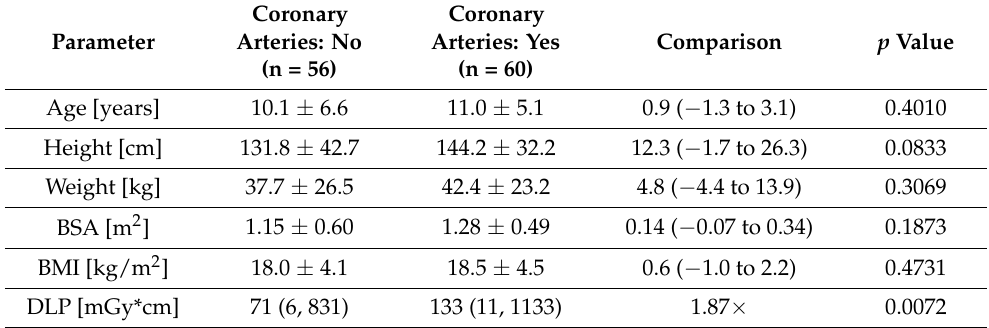
Table 3. Influence of coronary artery evaluation on the radiation dose of cardiac CT scan in